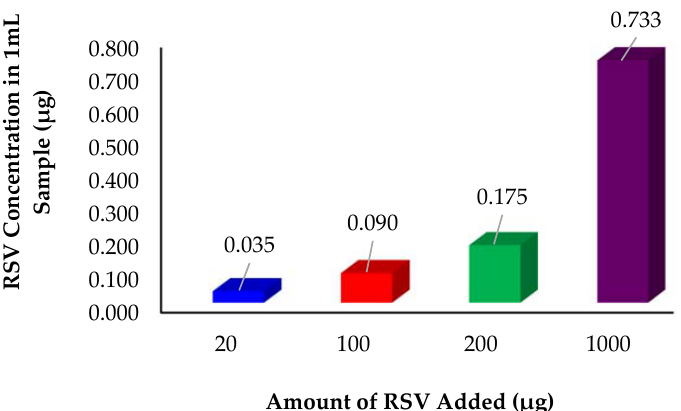
Figure 13. Reduction of resveratrol addition in excess in an attempt to save on overall drug required to hit target concentration. Mean RSV concentration ( n = 3), p < 0.05.